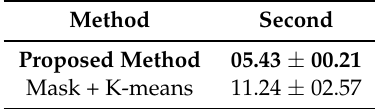
Table 8. The segmentation time of our proposed model has compared to the [13]